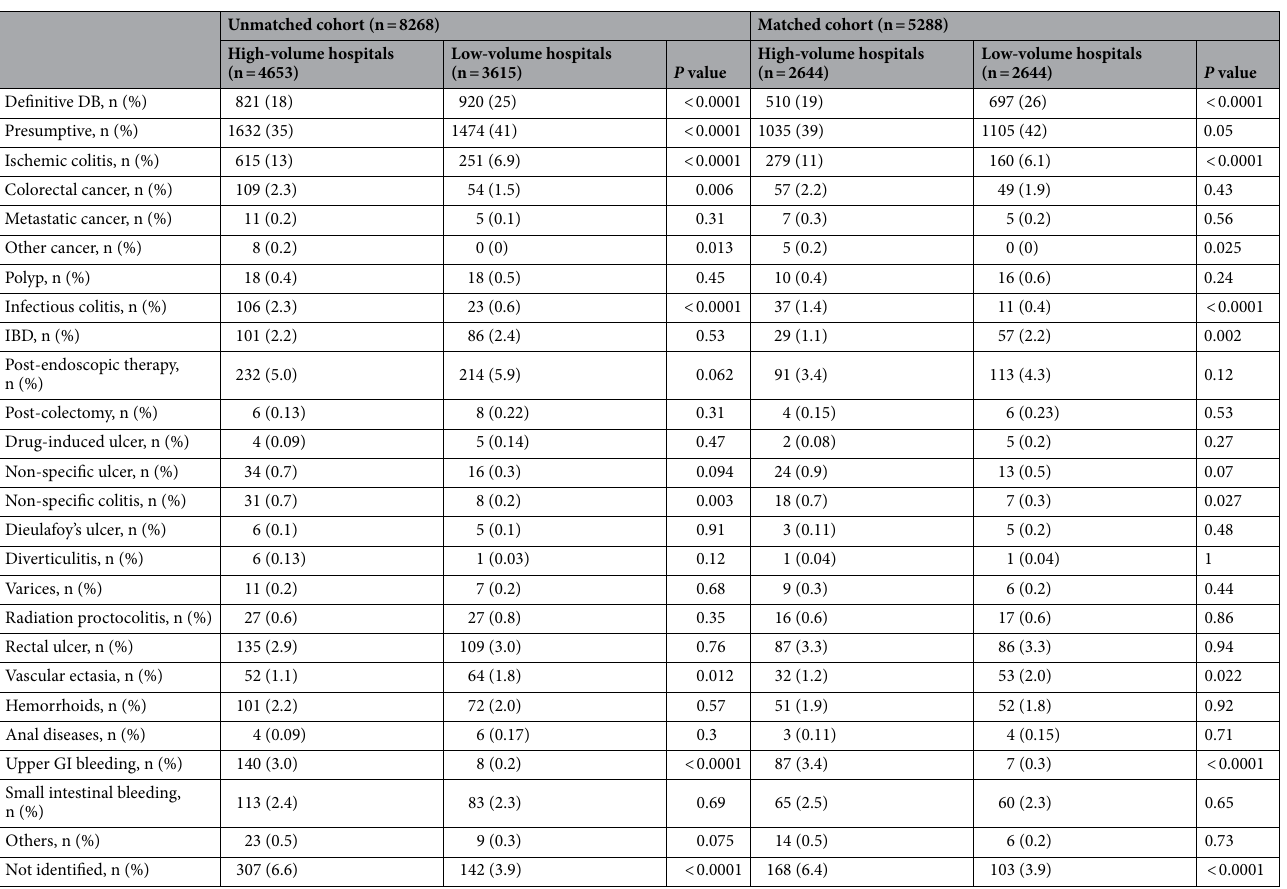
Table 3. Diagnosis in patients with acute hematochezia in the unmatched and the matched cohorts: high- volume versus low-volume hospitals. A two-tailed P -value < 0.05 was considered to indicate statistical significance. DB diverticular bleeding, IBD inflammatory bowel disease, GI gastrointestinal.